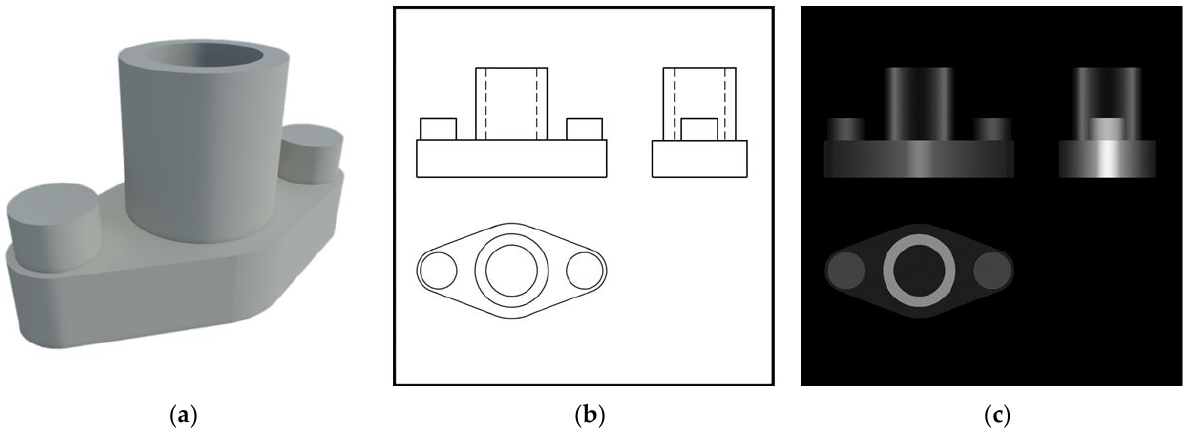
Figure 1. Relationship between TD and industrial radiology: ( a ) 3D view of the virtual part; ( b ) orthogonal views of the virtual part drawn according to TD norms; ( c ) orthogonal views of the virtual part represented as a simplified radiograph (with well ‐ defined edges).